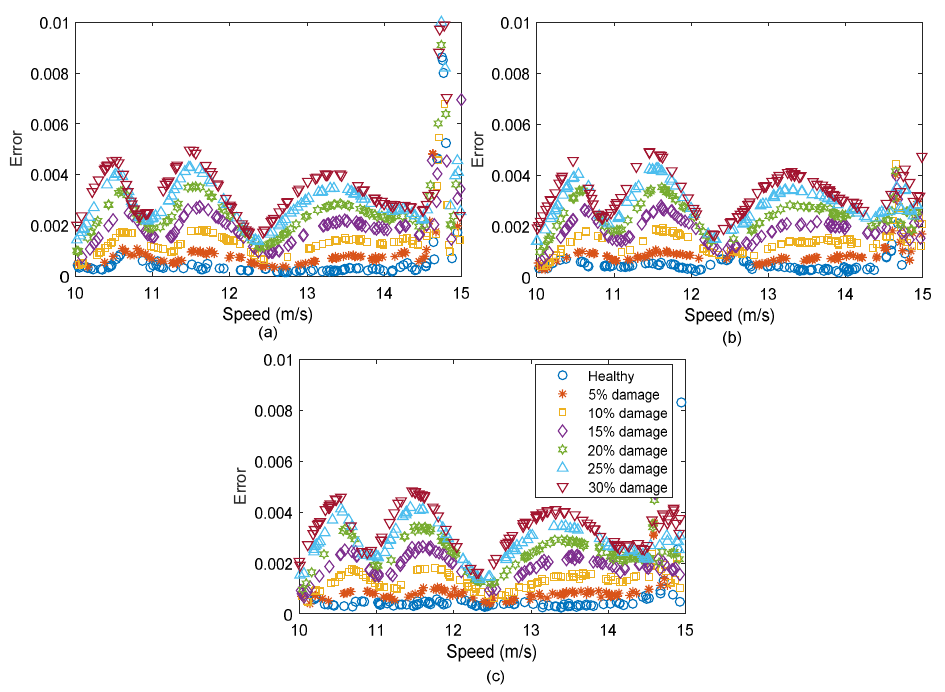
Figure 14. The prediction errors for ( a ) 1% added noise, ( b ) 3% added noise, and ( c ) 5% added noise.